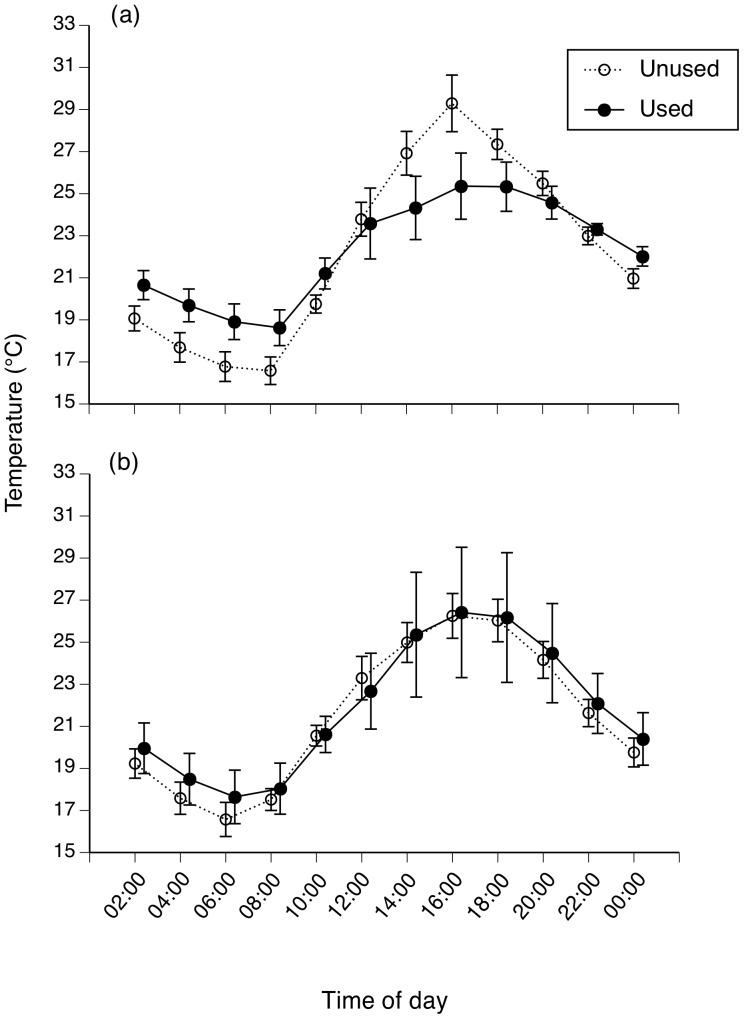
Thermal regimes in retreat-sites and potentially available retreat-sites.Panel (a) shows the temperature cycle on a hot day in the summer of 2010/2011 and (b) shows the same cycle on a hot day in the (cooler) summer of 2011/2012. Graphs show mean values and associated standard errors.